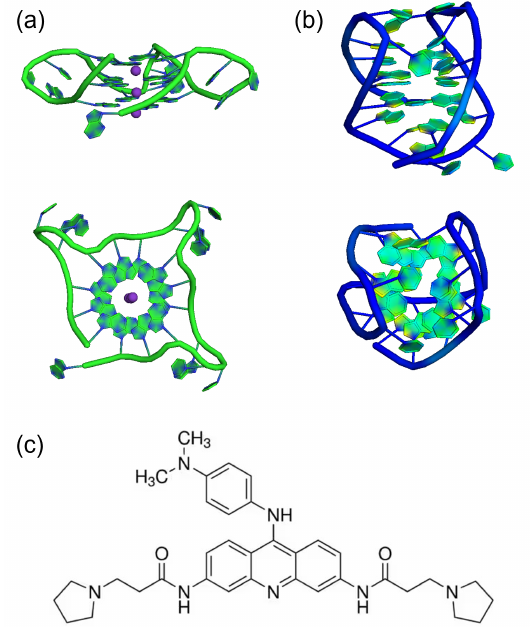
Figure 1. Cartoon representation of the PDB structures of AG 3 (TTAG 3 ) 3 (Tel22) with different cations: ( a ) Tel22 crystal structure in K + , PDB 1KF1 [25], ( b ) Tel22 structure in Na + , PDB 143D, as obtained from nuclear magnetic resonance experiments [24]. ( c ) Molecular structure of